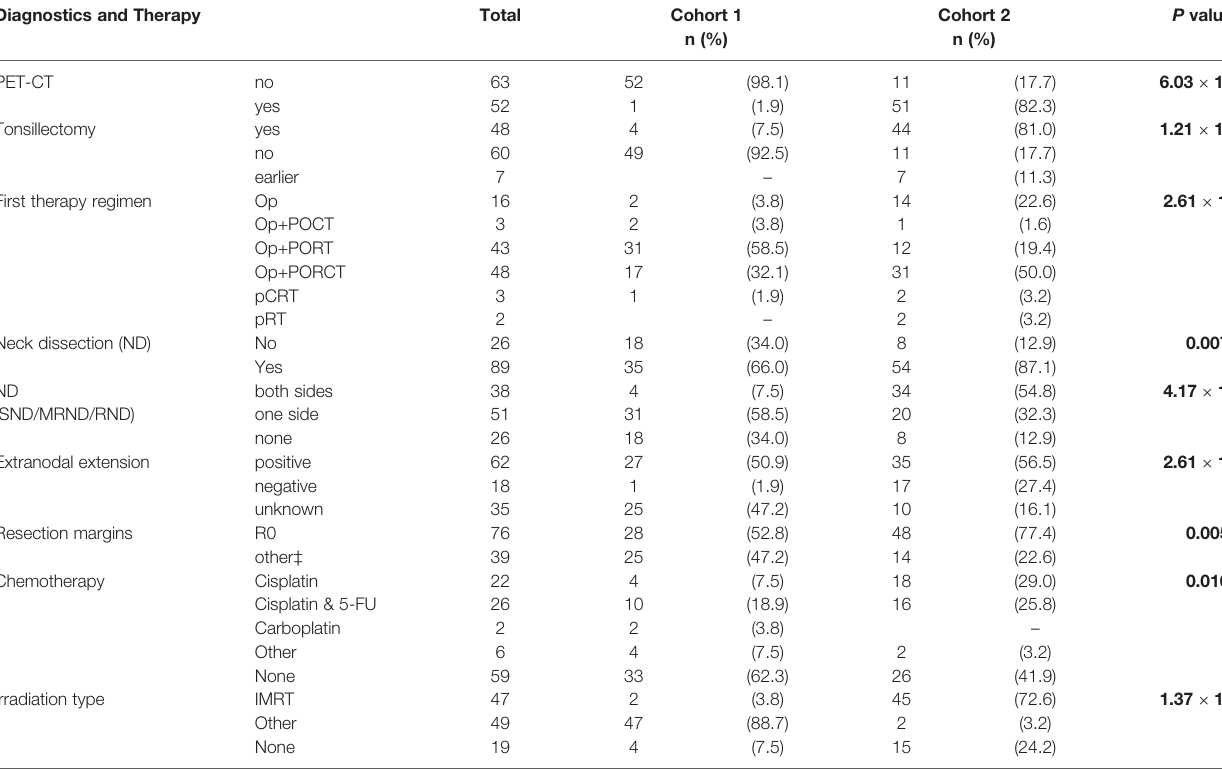
TABLE 2 | Diagnostic procedures and treatment regimens applied to neck squamous cell carcinoma of unknown primary (NSCCUP) patients of cohorts 1 and 2. Diagnostics and